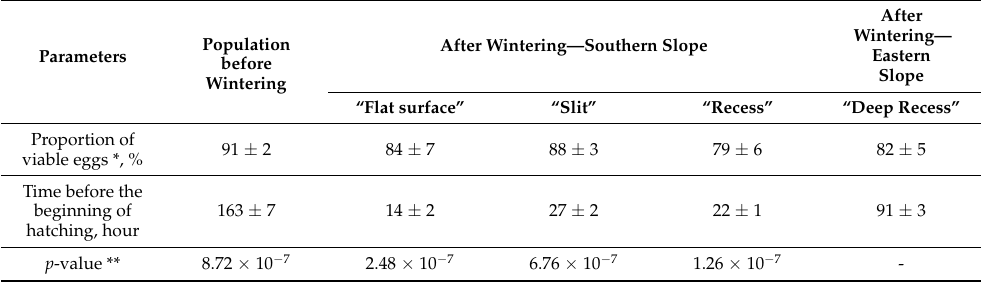
Table 3. Viability of SM eggs before and after wintering in rock microhabitats. Population Parameters before